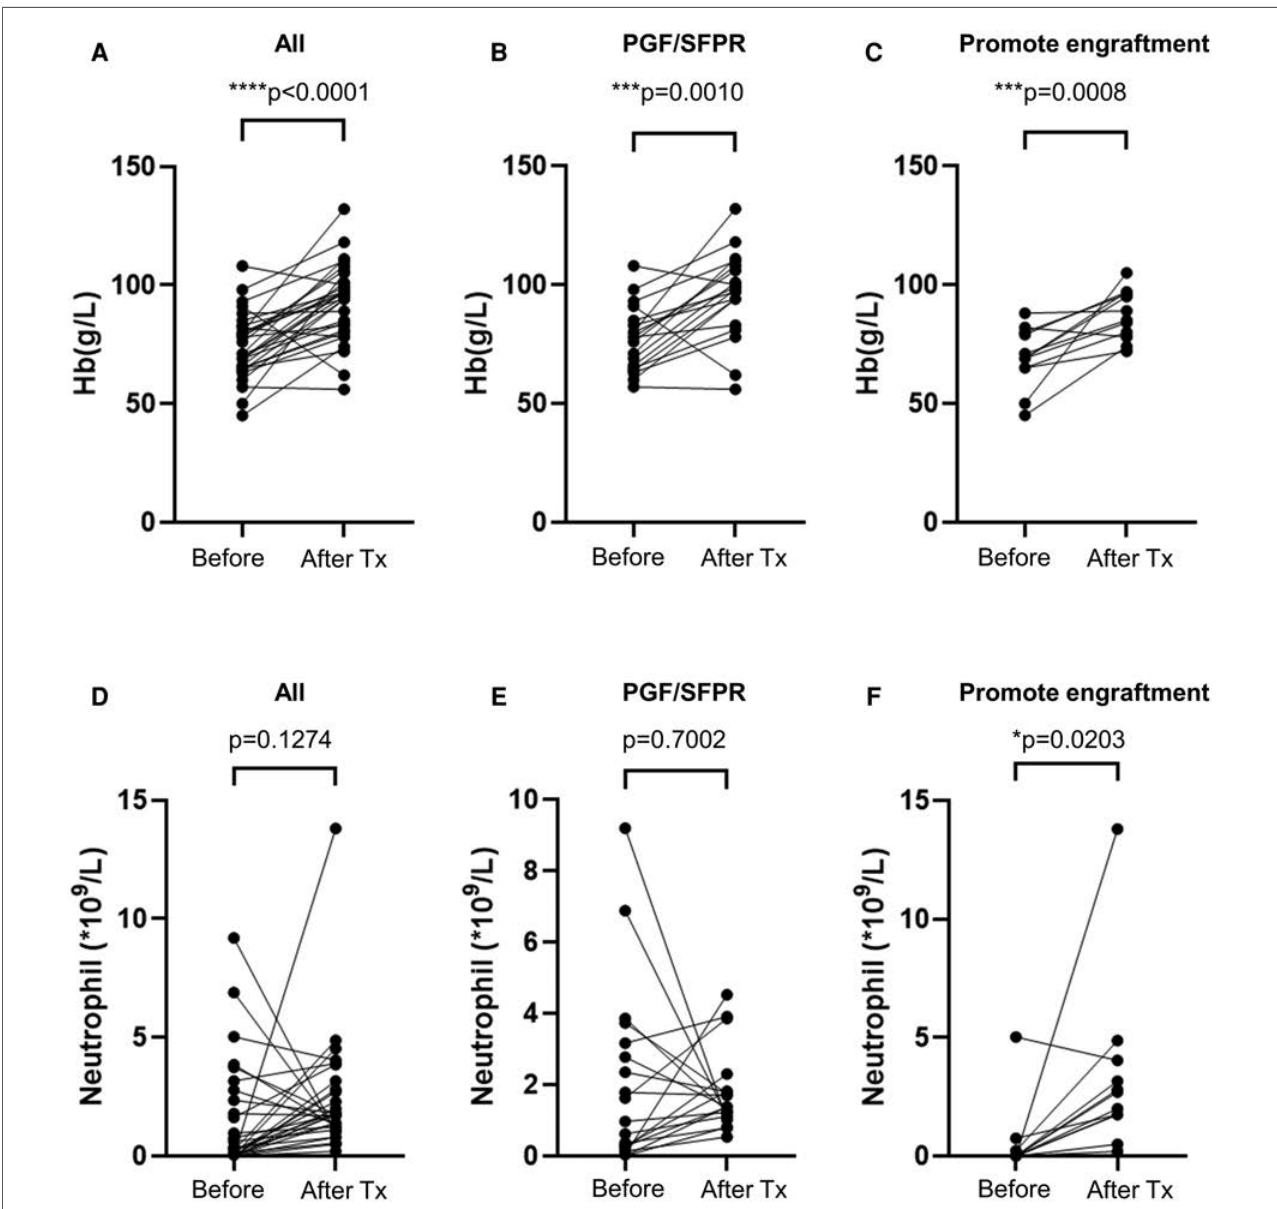
FIGURE 4 Avatrombopag affects hemoglobin and neutrophil level. ( A – C ) shows hemoglobin (Hb) level, while ( D – F ) shows the neutrophil level before treatment and after treatment (Tx). PGF, poor graft function; SFPR, secondary failure of platelet recovery. * p <0.05, *** p <0.001, **** p